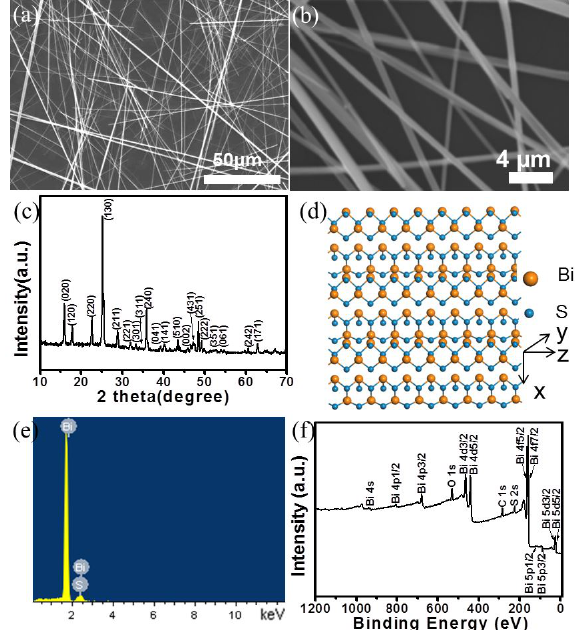
Fig. 1. (a) Representative SEM image of the Bi 2 S 3 NRs. (b) SEM im- age of the Bi 2 S 3 NRs at large magnification. (c) XRD pattern of the Bi 2 S 3 NRs. (d) Schematic illustration of the crystal structure of the Bi 2 S 3 . (e) EDX spectrum of Bi 2 S 3 NRs. (f) XPS spectrum analysis of the Bi 2 S 3